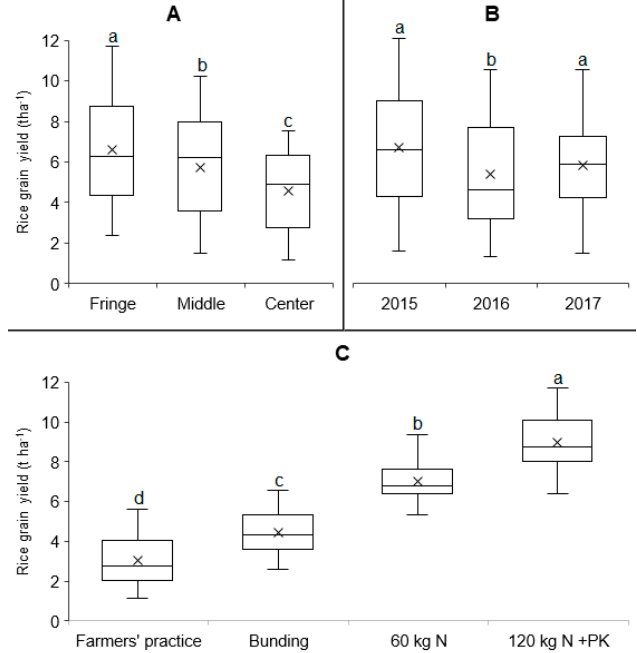
Figure 3. Source of grain yield variation of lowland rice due to ( A ) hydrological position, ( B ) year and ( C ) land and mineral N management with farmers practice as a control, X = arithmetic mean, = median. Different letters indicate significant differences by Tukey test at p ≤ 0.05.